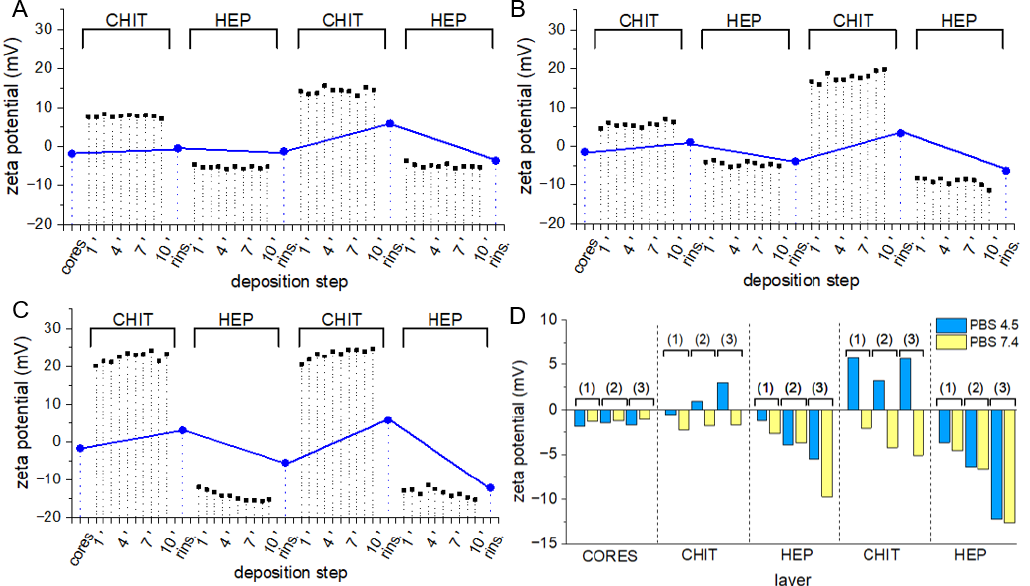
Figure 7. ζ potential changes in the course of CHIT/HEP coating deposition in PBS pH 4.5 on ( A ) PCL, ( B ) PLA-co-PCL, and ( C ) PLGA cores. Blue dots represent ζ potential values after deposition of each monolayer and subsequent rinsing, black squares depict in situ changes in ζ potential over 10 min of exposition to polyelectrolyte solution; ( D ) ζ potential values of (1) PCL, (2) PLA-co-PCL, and (3) PLGA cores coated with four subsequent CHIT/HEP monolayers resuspended in PBS 4.5 (blue) and PBS 7.4 (yellow).